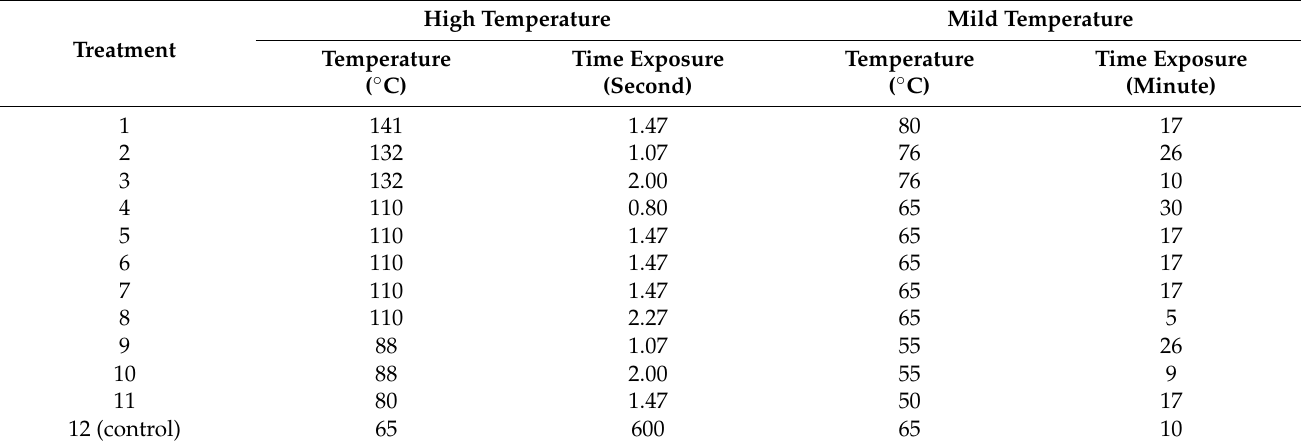
Table 1. Diet treatments used in 2-factorial experiments to rear western corn rootworm